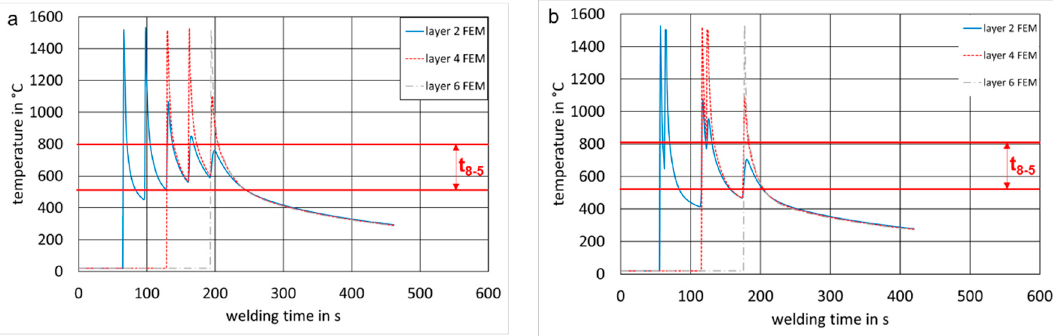
Figure 8. Comparison of measured and simulated temperatures depending on welding orientation for G4Si1 with v wire = 5.0 m/min and v welding = 40 cm/min: ( a ) discontinuous/unidirectional; ( b ) continuous/multidirectional.